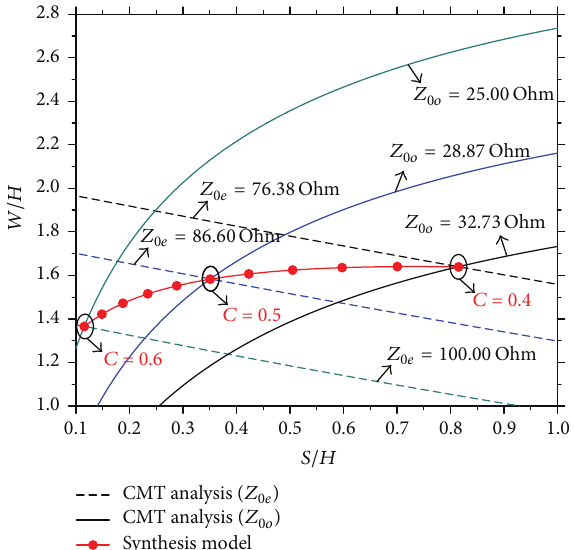
Figure 4: Comparison of results obtained from ANN-based syn- thesis model and CMT analysis contours for the PCMLFGPC with = 9.8 , 𝑊 /𝐻 = 3 , 𝑆 /𝐻 = 0.5 , and 𝑍 = 50 𝜀 𝑟 𝑓 𝑔 0